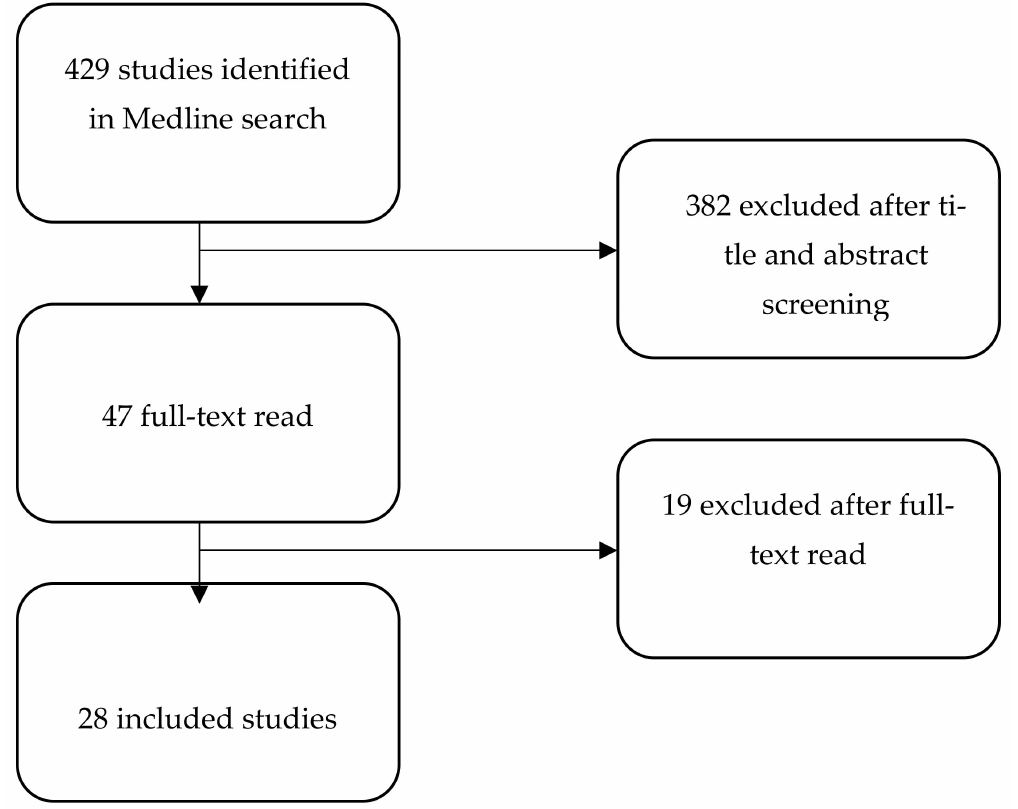
Figure 4. Selection of included